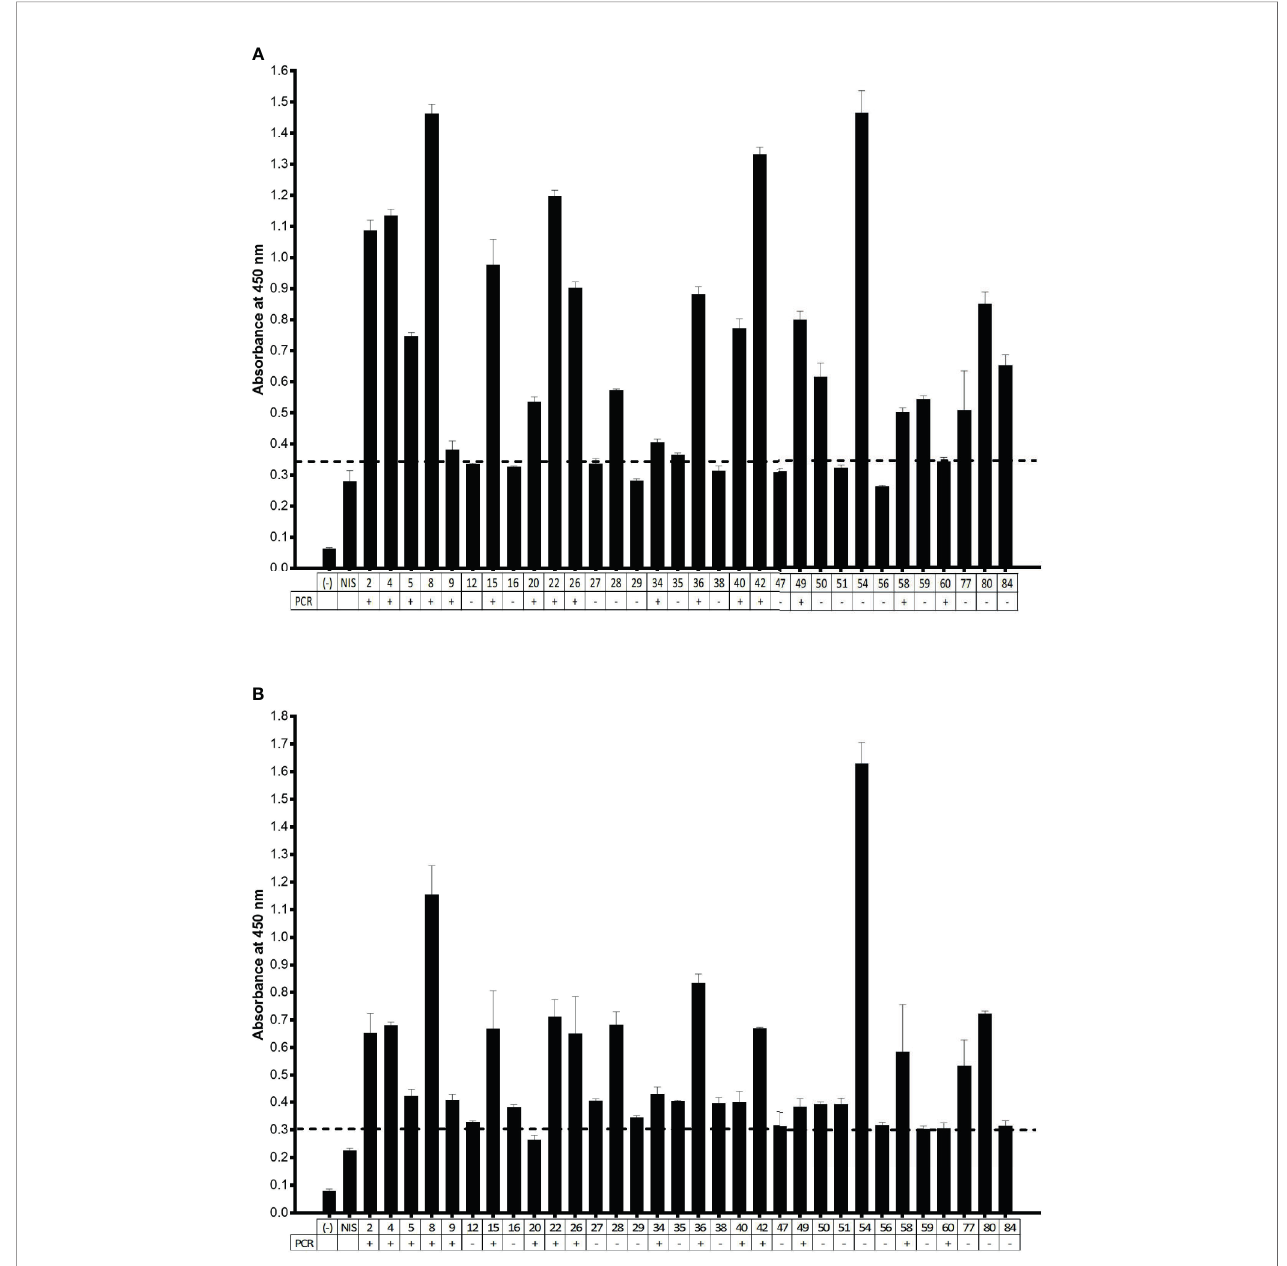
FIGURE 3 | ELISA assay for IgG detection in human samples. (A) Serum samples diluted 1:100 were incubated to N protein-coated ELISA plates. (B) Serum samples diluted 1:100 were incubated to 3CL protein-coated ELISA plates. ( − ) negative control, absence of serum; NIS: non-immune human serum. the PCR status of nasal and oropharyngeal swab related to serum donors is indicated below the graph. Cutoff was set to NIS × 1.3. Representative experiment of two independent